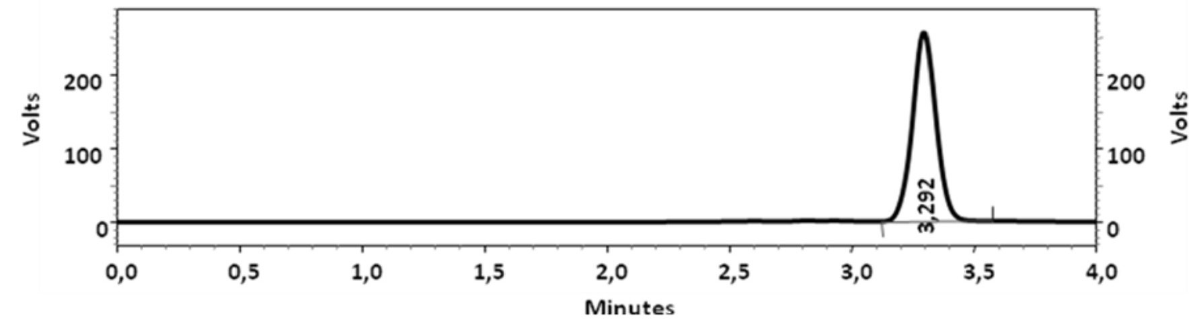
(250 x 4.6 mm, i.d., 4 µm particle 18